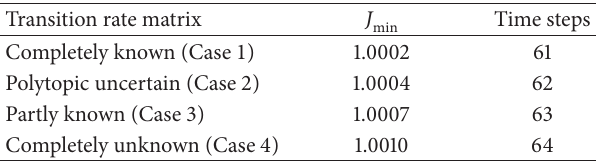
Table 1: Computation results for four different reduced-order FD filters cases.